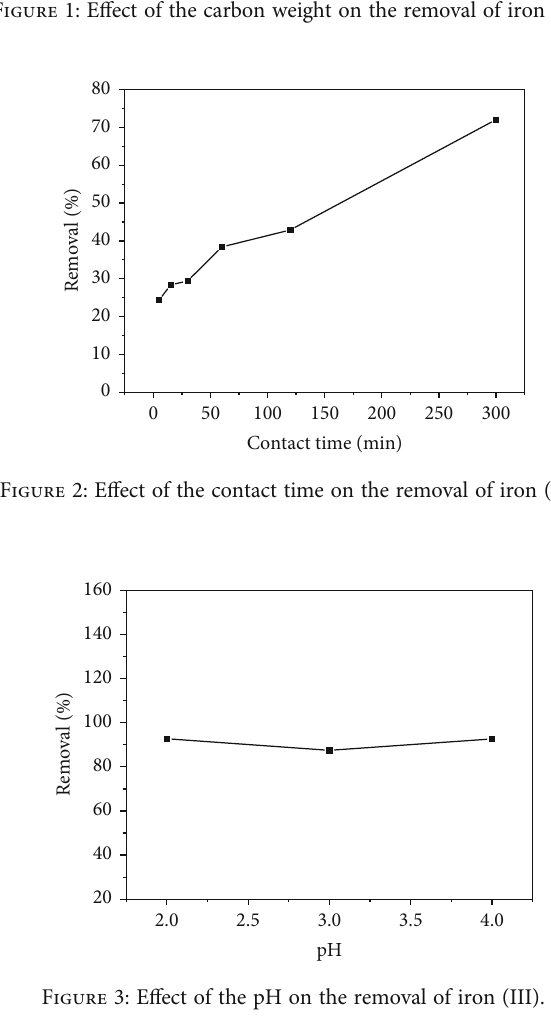
Figure 1: E ff ect of the carbon weight on the removal of iron (III).